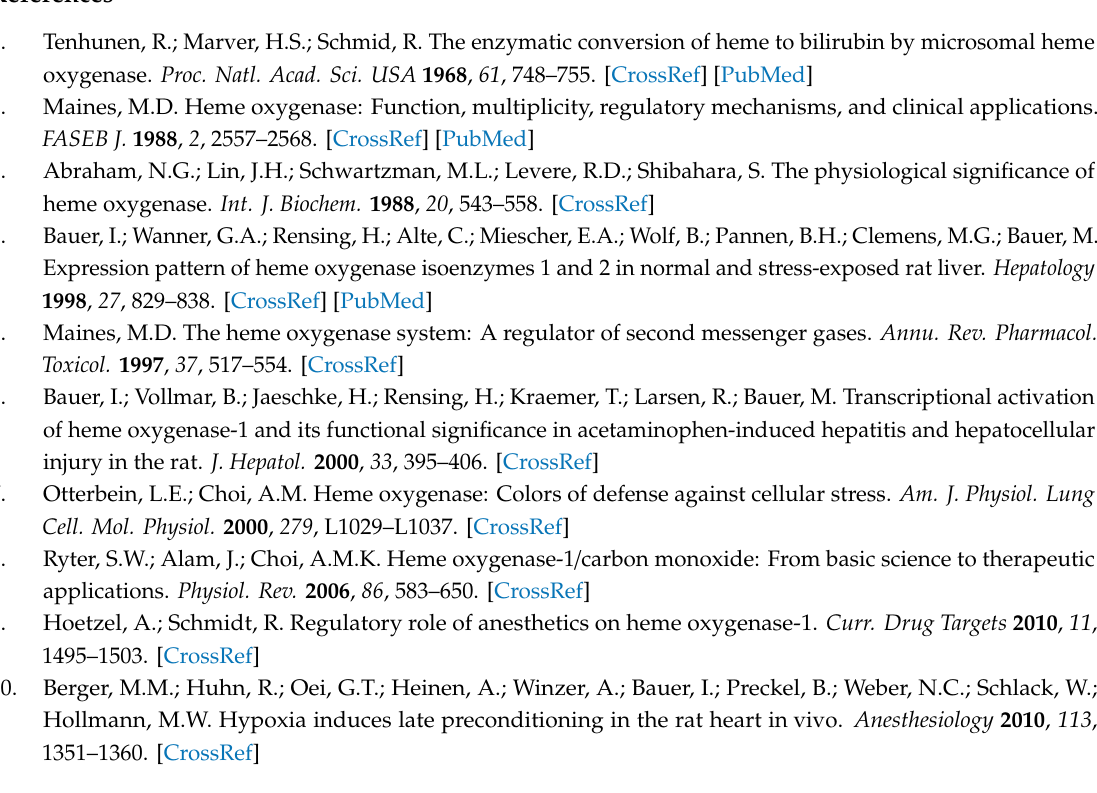
Table S1: Conditioning with anesthetics and its e ff ect on HO-1 and organ protection, Table S2: Remote ischemic conditioning and its e ff ect on HO-1 and organ